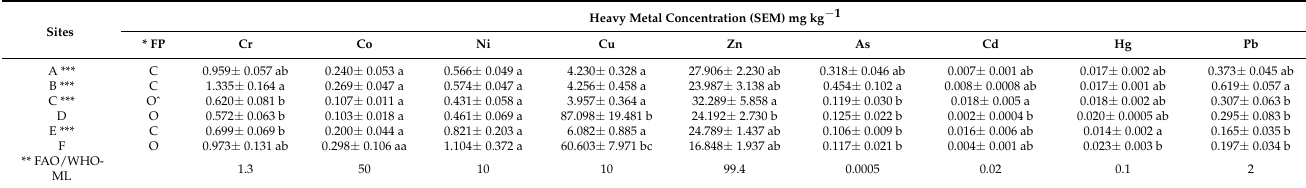
Table 5. Average concentrations of selected heavy metals in grapevine leaf samples from different sites (vineyards) in the Cape Winelands.